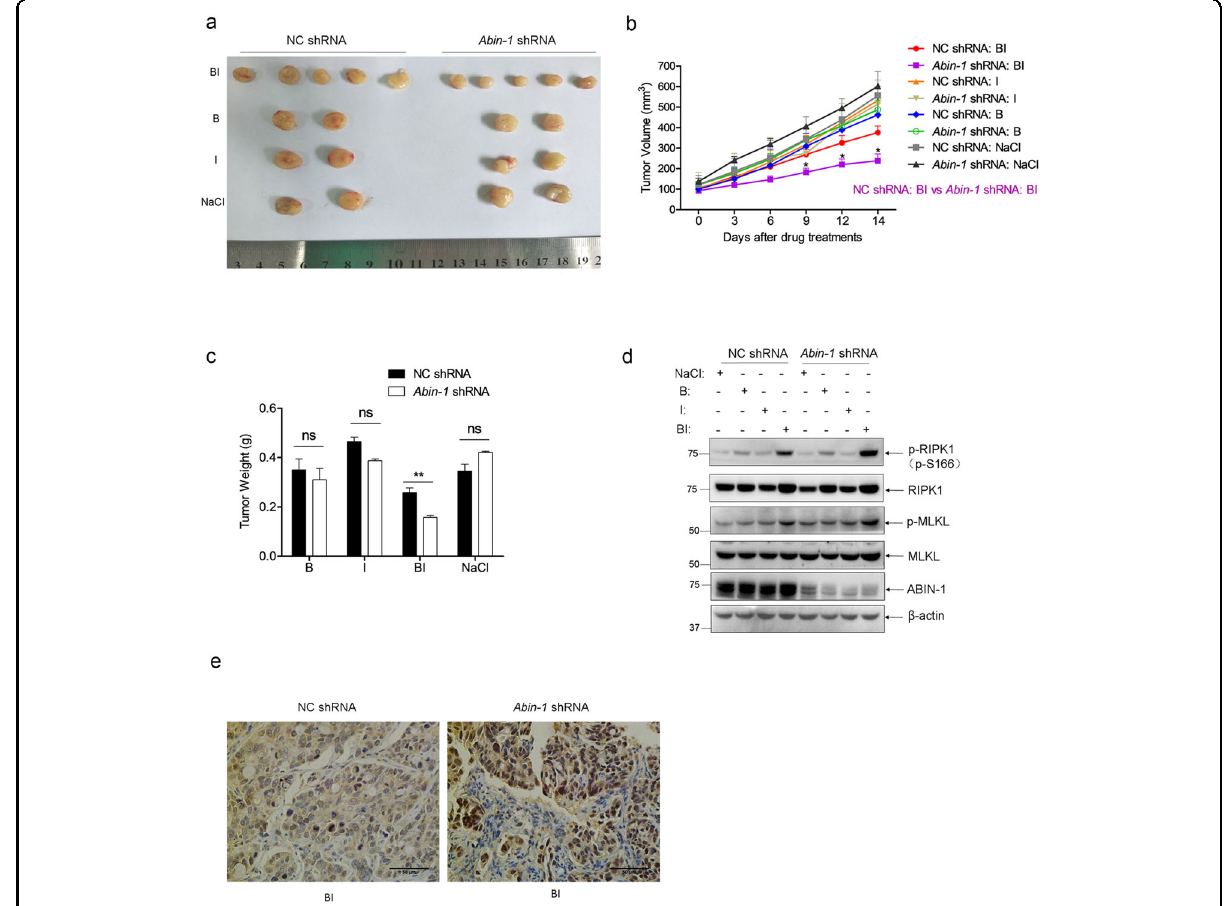
Fig. 5 ABIN-1 de fi ciency improves birinapant + IDN-6556-induced necroptosis cancer therapy. HT-29 cells were transduced with lentivirus- based control shRNA (NC shRNA) or Abin-1 shRNA and screened with puromycin for 5 days to establish stable knockdown pool cells. NC shRNA cells and Abin-1 shRNA cells were subcutaneously injected into the left and right fl ank of BALB/c nude mice, respectively. When tumors grew to 100 mm 3 , mice were divided into four groups (normal saline (NaCl), n = 2; IDN-6556 (I), n = 2; birinapant (B), n = 2; birinapant + IDN-6556 (BI), n = 5). Mice were intraperitoneally injected with indicated drugs every three days. Tumor volumes were measured every 2 or 3 days, and mice were sacri fi ced 14 days after the fi rst drug injection. Tumors were isolated for imaging, weighing, western blot, and immunohistochemical staining. Birinapant, 2.5 mg/kg and IDN-6556, 1.25 mg/kg. a Tumors images. b Tumor volumes. Volume (mm 3 ) = 0.5 × length (mm) × width 2 (mm 2 ). c Tumor weights (g). d Western blot analysis for necroptosis markers. Each lane was loaded with a randomly selected tumor sample from each group. e Immunohistochemical staining with phospho-RIPK1 of tumor samples in BI group. * P < 0.05, ** P < 0.01, or *** P <